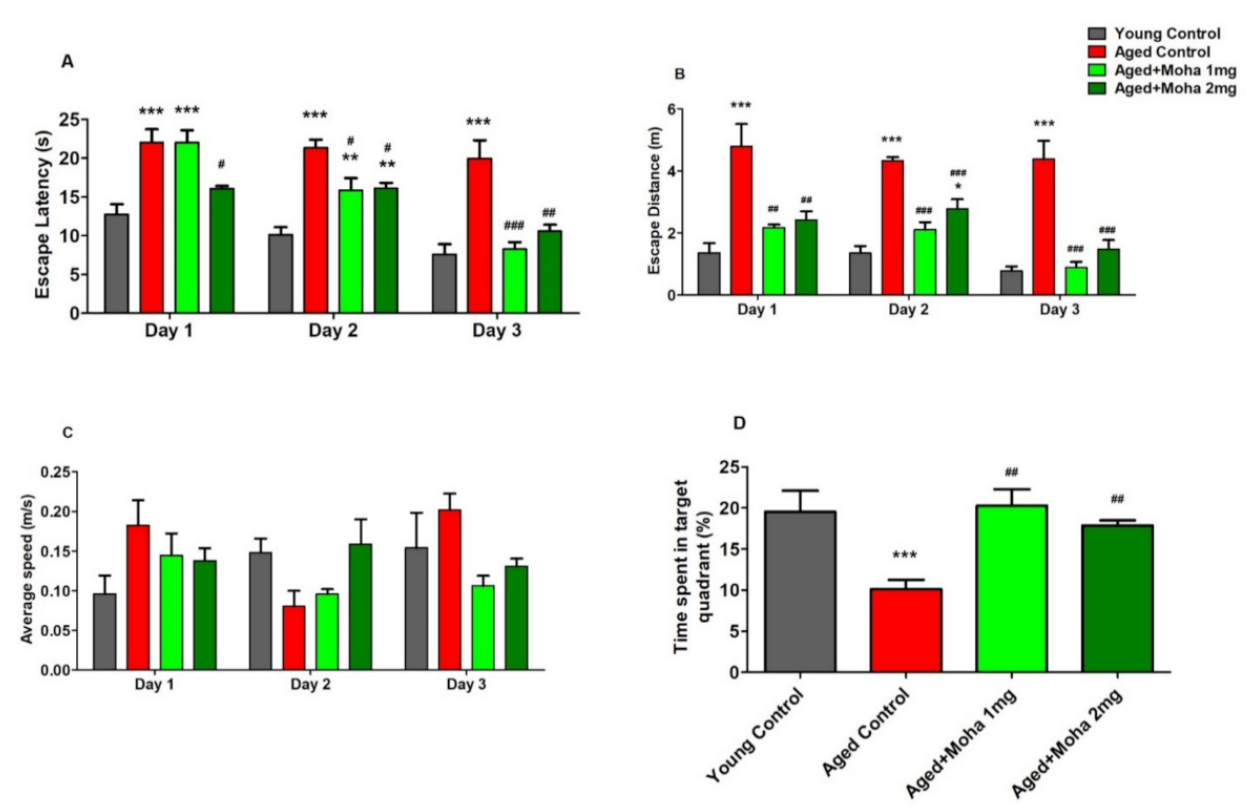
Figure 2. Effect of mahanimbine on ( A ) escape latency, time taken to find the hidden platform. ( B ) Escape distance, distance traveled from starting point until finding the hidden platform; ( C ) av- erage speed, swimming speed of animal to find the hidden platform; ( D ) probe test, aged mice’s percentage time spent in the target quadrant using Morris water maze test. There were significant improvements in escape latency and escape distance with mahanimbine in aged mice. Additionally, treatment increased the time spent in the target quadrant of aged mice. All data were expressed as mean ± SEM ( n = 6). One-way ANOVA (day 1: F (3,20) = 11.74, p < 0.001, day 2: F (3,20) = 17.38, p < 0.001 and day 3: F (3,20) = 14.88, p < 0.001 for escape latency; day 1: F (3,20) = 12.22, p < 0.001, day 2: F (3,20) = 28.62, p < 0.001, and day 3: F (3,20) = 23.15, p < 0.001 for escape distance; day 1: F (3,20) = 1.939, p > 0.05, day 2: F (3,20) = 3.467, p > 0.05, and day 3: F (3,20) = 2.497, p > 0.05 for average speed; F (3,20) = 7.185, p < 0.01 for probe test followed by Tukey–Kramer multiple comparisons test. ** p < 0.01 and *** p < 0.001 in comparison with young control, # p < 0.05, ## p < 0.01, and ### p <